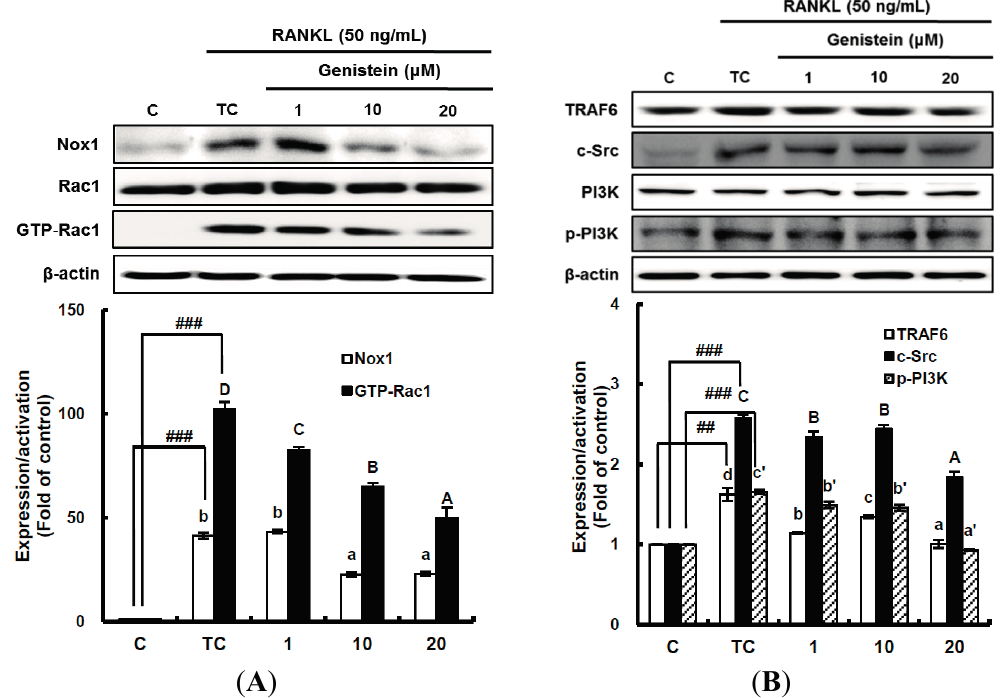
Figure 4. The effect of genistein on the translation and activation of NADPH oxidase (Nox1) ( A ) and its upstream signals ( B ). RAW 264.7 cells were exposed to the receptor activator of nuclear factor kappa-B ligand (RANKL) (50 ng/mL) for two days in the absence and presence of genistein. GTP-Rac1 was recovered by centrifugation from proteins complexed to the beads, which have a glutathione S -transferase-p21-binding domain: human Pak1 as 67–150 and binds to GTP-bound Rac1 of the lysates. Western blotting analysis was performed on the lysates of cells that had been incubated with 1–20 μ m genistein. Different corresponding letters indicate significant differences at p < 0.05 by Duncan’s test. ## p < 0.01, ### p < 0.001 vs. C (C: control, which was not treated; TC: treated control, which was treated with